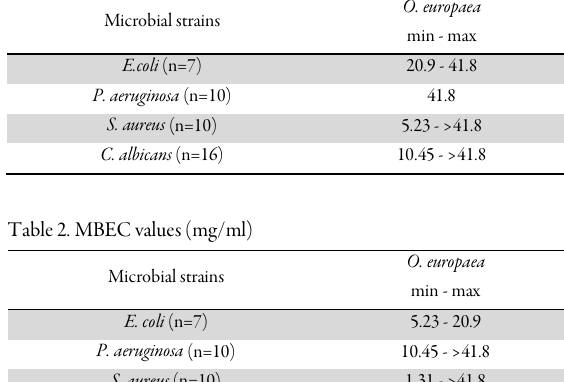
Table 3. The values of MFI for PI stained microbial cells exposed to O. europaea oil at 1/2 × MIC Plant EOs Microbial strains